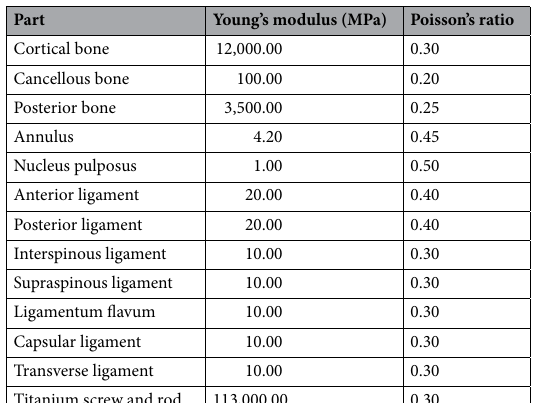
Table 1. Material properties of L1–S1 vertebrae FE model